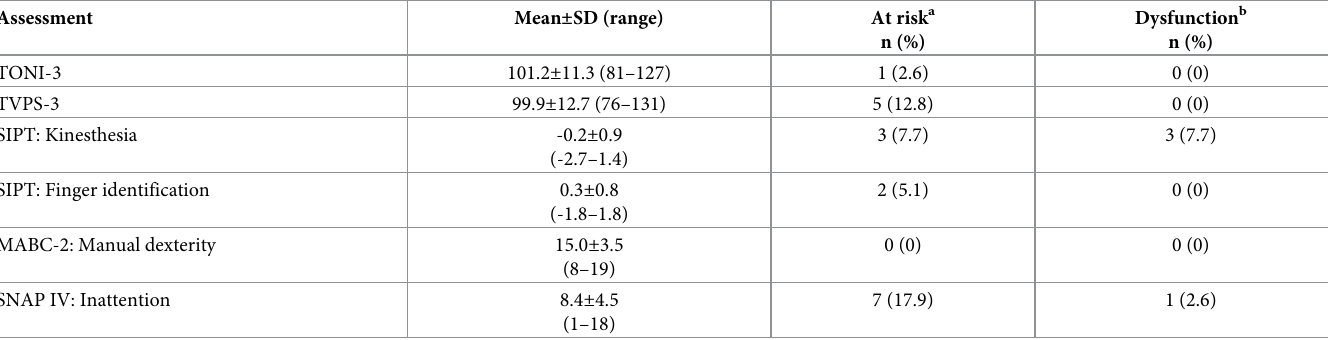
Table 3. Sensory, perceptual, and motor function in the preterm subgroup (n = 39). Assessment